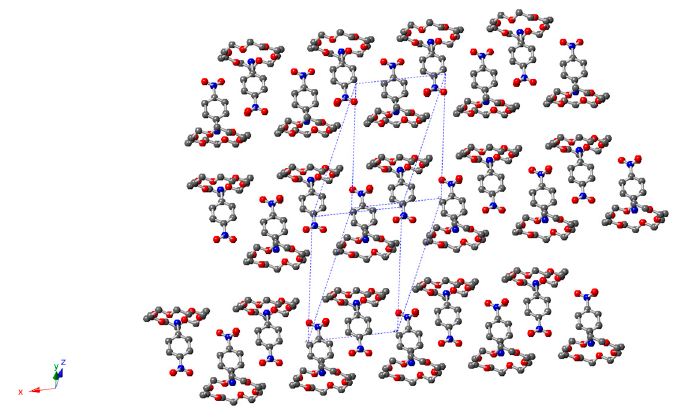
Figure 3. Packing of supramolecular cation (4-nitroanilinium)(18-crown-6) view along the a axis.